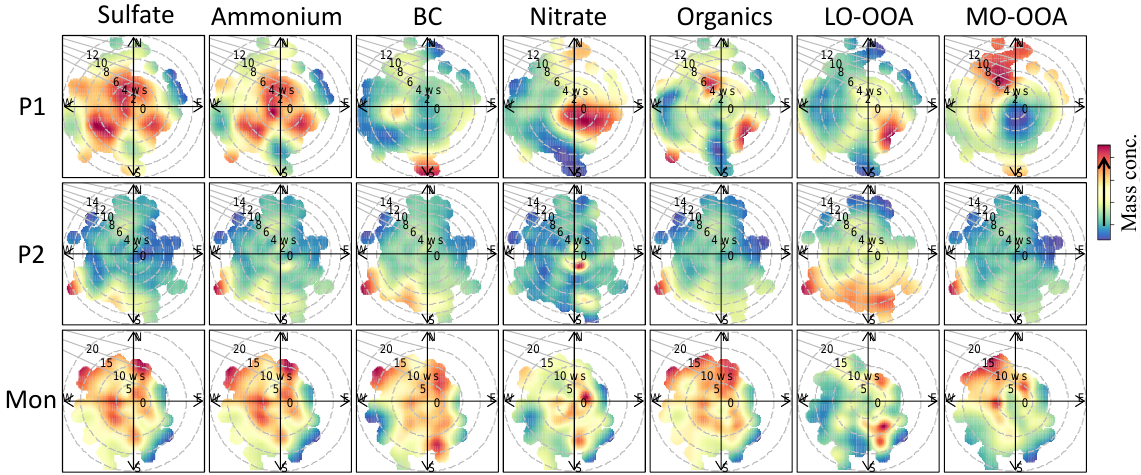
Figure 6. Bivariate polar plots that illustrate the variations of the concentrations (colored) of each species as a function of wind speed (ms − 1 ) and wind direction during different periods of the